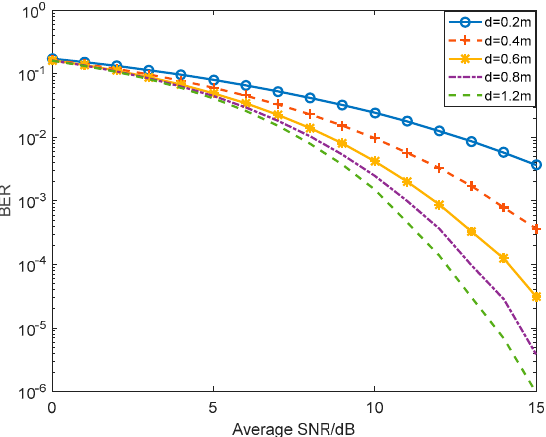
Figure 9. The BER performance of various aperture diameters based on experience data.